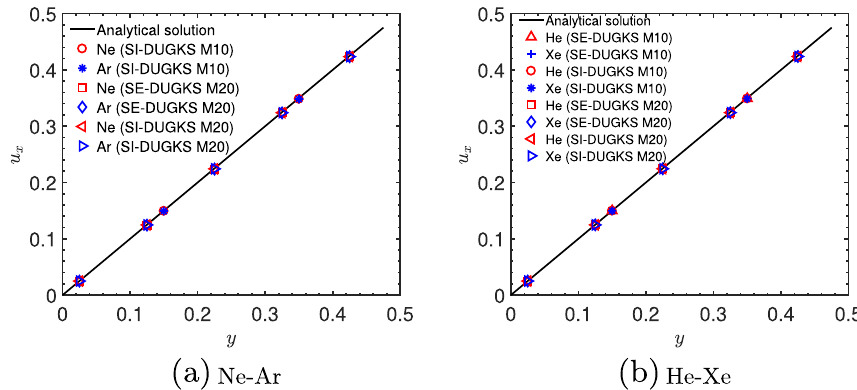
Fig. 14 Velocity profiles in the Couette flow with 𝛿 = 1000 . M10 and M20 represent the results with 10 and 20 mesh points in the y direction,